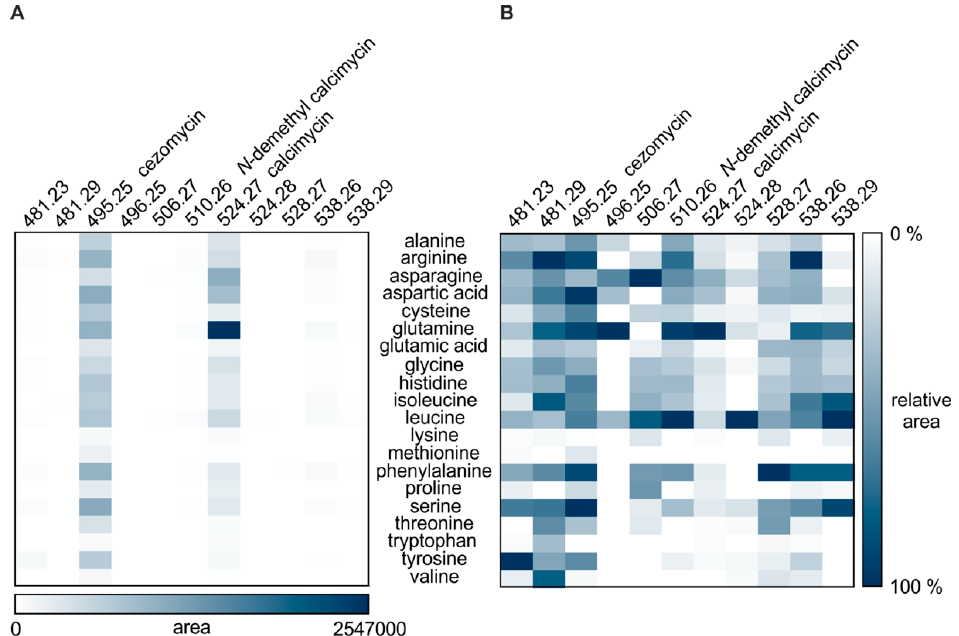
Figure 2. Relative abundance of calcimycin and analogs in culture supernatants of S. chartreusis cultivated in chemically defined medium supplemented with amino acids. ( A ) Mean abundance of each analog is displayed in relation to the highest area value determined in the entire calcimycin metabolic network. ( B ) Mean abundance of each analog is displayed in relation to the highest area value measured for the given analog across all cultivation conditions. Metabolites were extracted from the culture supernatants and analyzed by LC-MS/MS. Abundance was calculated based on area under the curve. Background signal was subtracted and mean values were calculated from the replicates. The relative abundance of an analog is displayed in a gradient of white to blue, with blue representing high abundance and white representing absence (cut-off level). All experiments were performed in biological triplicates, except the experiment with glutamine, which was performed in duplicate. Masses are shown with two decimal places (see Table 2 for all four decimal places). Calcimycin: [M+H] + 524.27, cezomycin: [M+H] + 495.25, N -demethyl calcimycin: [M+H] + 510.26, others: structurally un- known.